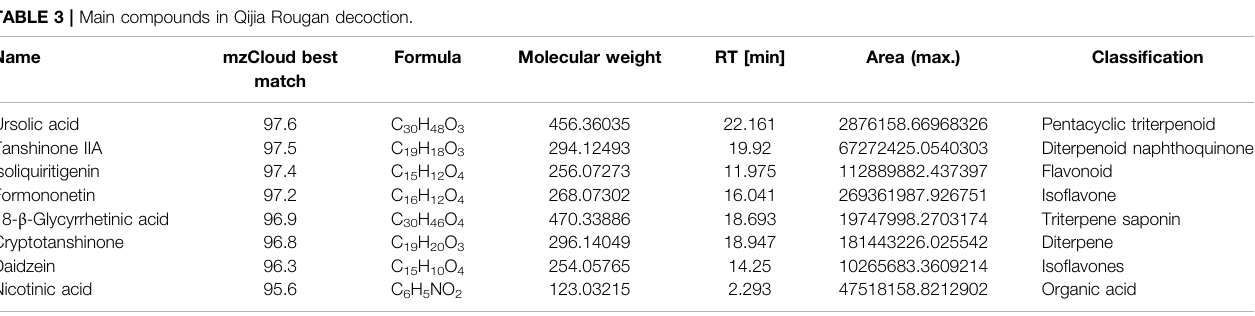
TABLE 3 | Main compounds in Qijia Rougan